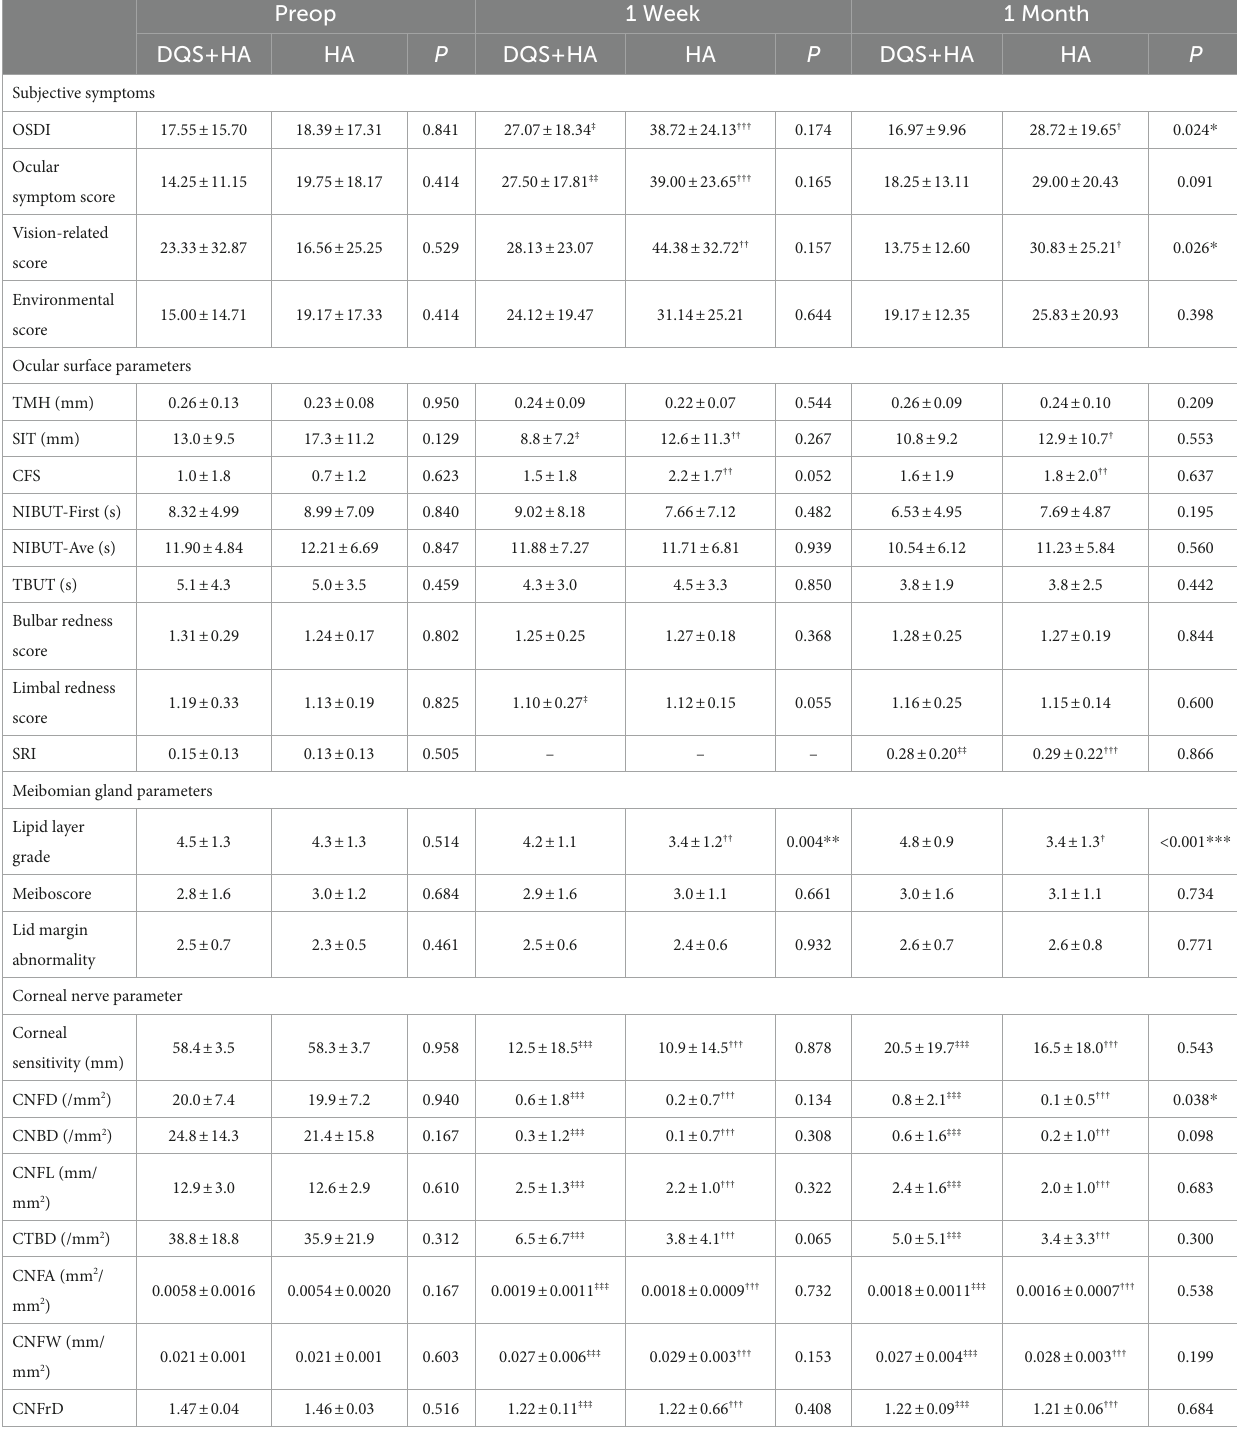
TABLE 1 Changes in dry eye parameters, meibomian gland parameters and corneal nerve parameters in the combination group and the HA group.